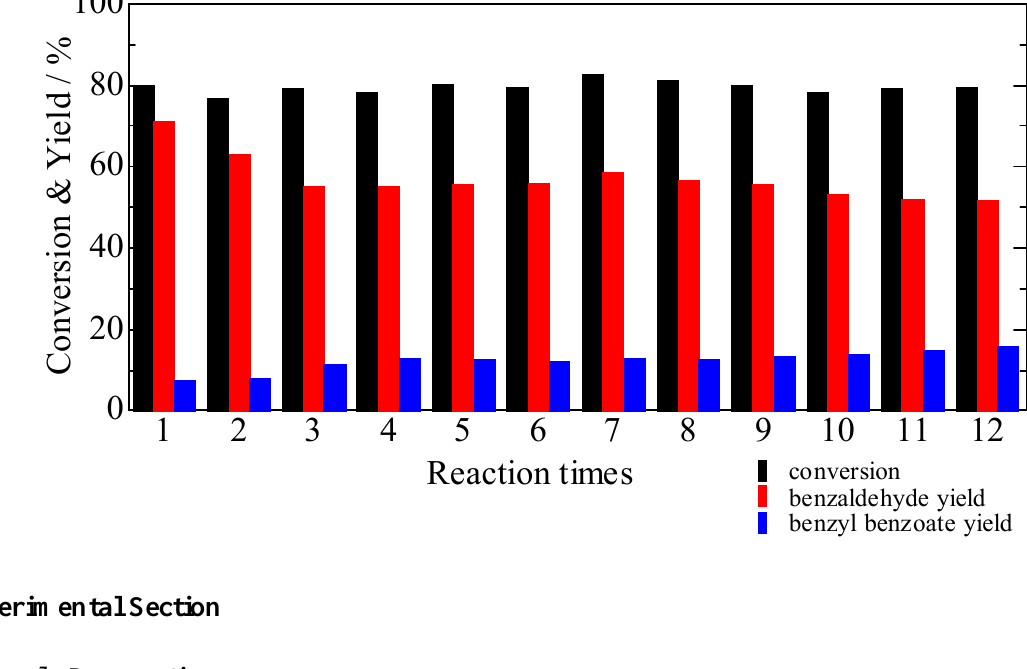
Figure 10. Catalytic performance of Au/USY zeolite treated at 773 K in 6% hydrogen in repetitive aerobic oxidation of benzyl